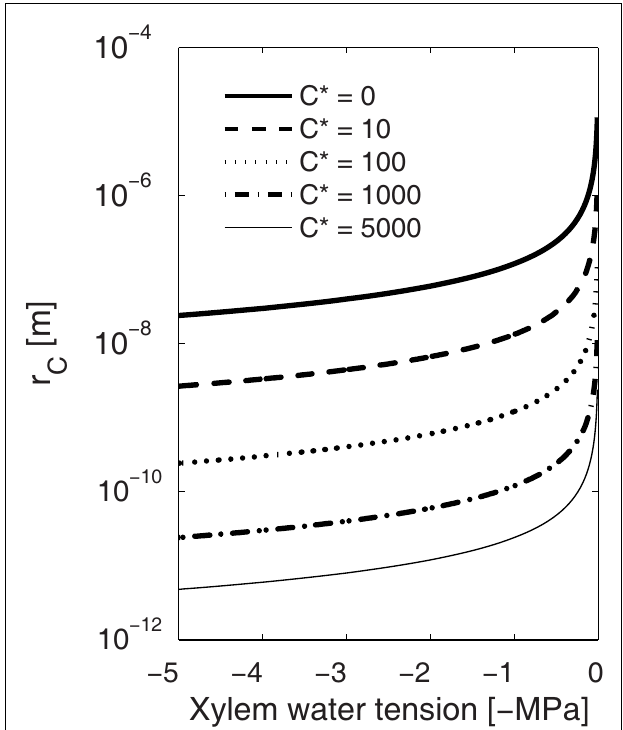
FIGURE 6 | Dependence of the critical radius ( r c ) of a gas bubble on xylem water tension at different solute concentrations ( C ∗ ). Bubbles larger than r c at a certain tension will grow spontaneously and smaller will redissolve to the solution. Similarly, during thawing, smaller bubbles than r c are more likely to redissolve, and the higher the xylem water tension or gas concentration the smaller the bubble has to be to redissolve.This means that while bubble formation is more likely at high freezing velocities (high Pe leads to high C ∗ ), the small bubbles are more likely to redissolve during thawing than bubbles that may form during slow